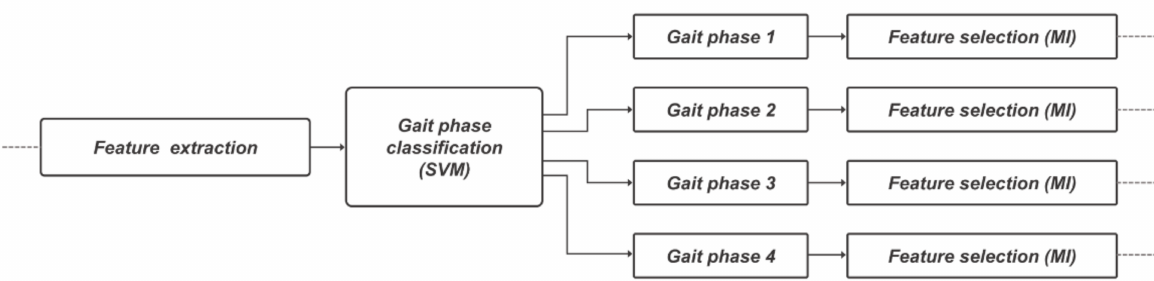
Figure 6. Details of gait phase-based feature engineering process using support vector machine and mutual